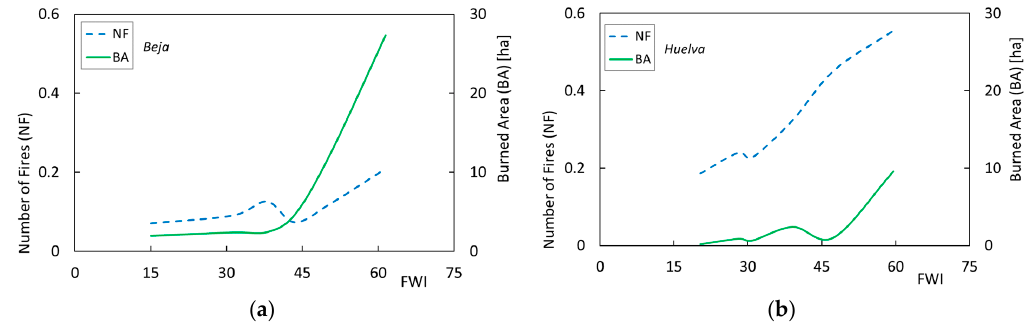
Figure A11. Average number of daily fires (NF) and burned area (BA) as a function of FWI for: ( a ) the Portuguese District of Beja and ( b ) the Spanish Province of Huelva.